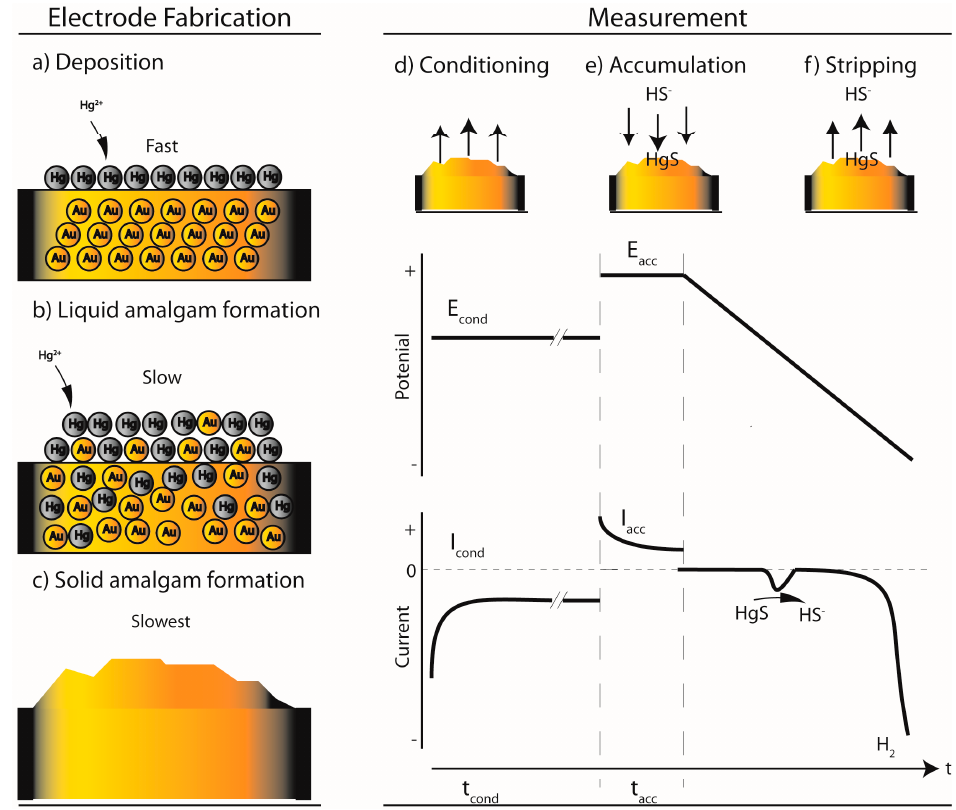
Figure 1. Scheme of gold amalgam formation ( a – c ) and cathodic stripping voltammetry ( d ). Mercury (Hg) deposition on polished gold (Au). ( b ) Diffusion of gold into mercury-forming liquid amalgam and vice versa. ( c ) Solid gold amalgam formation through crystallization. ( d ) Conditioning potential E cond is applied for t cond . ( e )The accumulation potential E acc is applied for t acc . ( f ) Lastly, a cathodic sweep is performed at a speed υ sweep . Its current wave peak is proportional to the analyte concentration according to the Randles-Sevcik equation [22]. Sulfide peak was expected at potentials below − 0.6 V vs. Ag/AgCl.